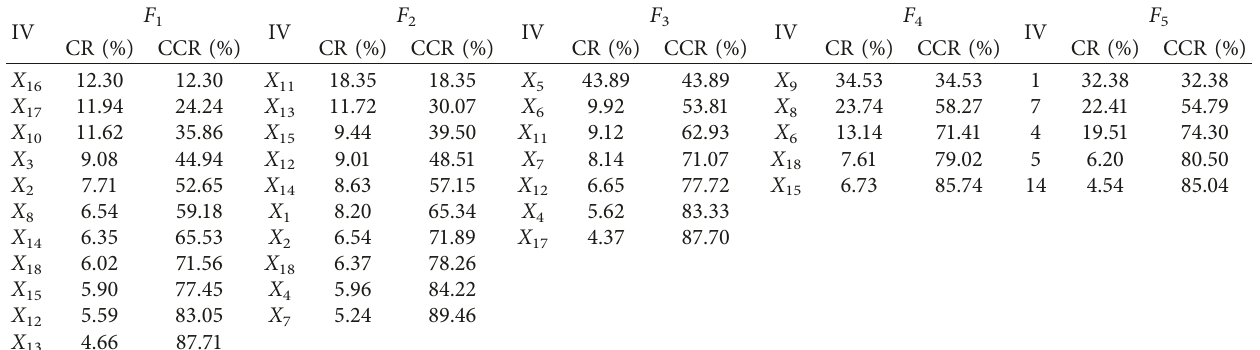
Table 4: Contribution rate (CR) and cumulative contribution rate (CCR) of individual variables (IV) to